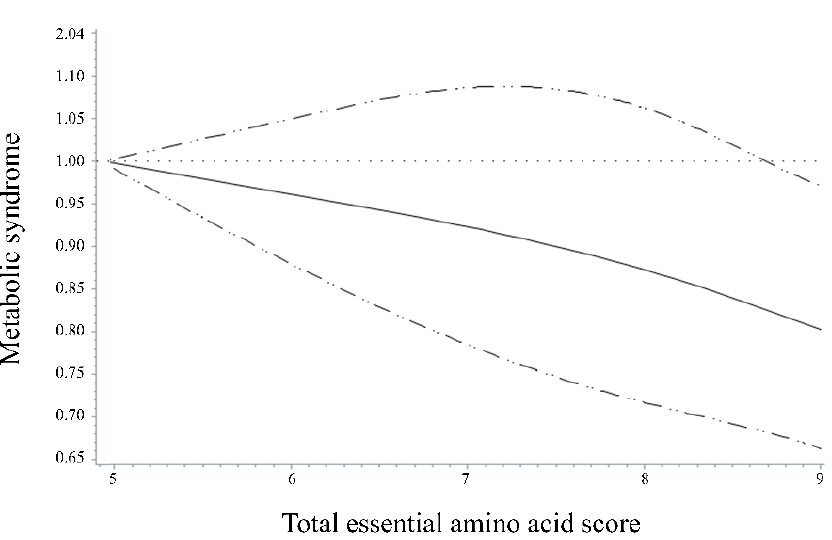
Figure 1. Odds ratios (95% confidence intervals) for the non-linear relationship between the total essential amino acid score and metabolic syndrome, evaluated with restricted cubic splines. Solid line indicates the odds ratios and dotted lines indicate the 95% confidence intervals. The model was adjusted for age, sex, education level, household income, alcohol consumption, smoking status, BMI, physical activity, and total energy intake. p for nonlinearity = 0.6.